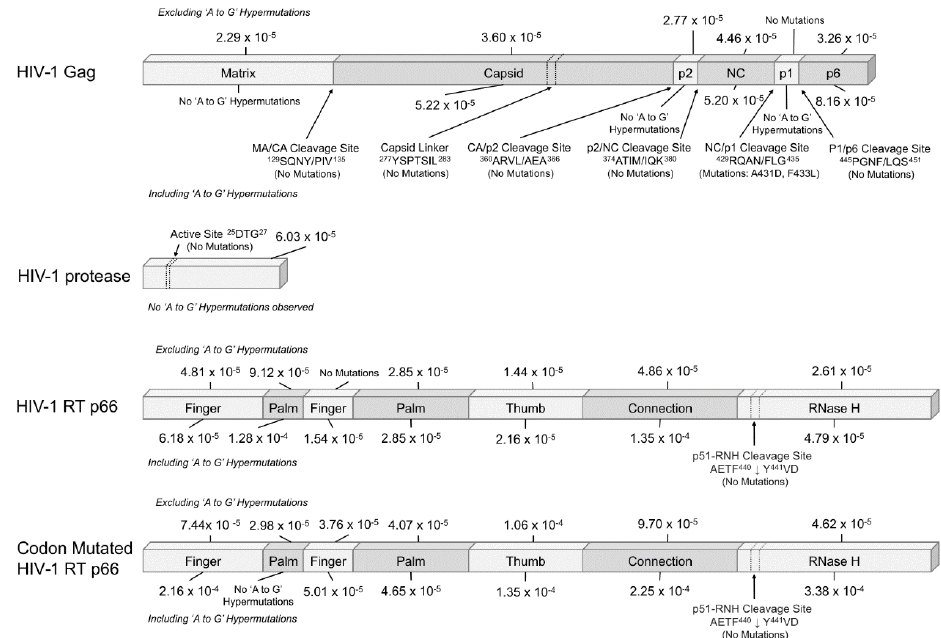
Figure 4. Mutation rates (mutations/bp) calculated in the domains of HIV-1 Gag, protease, RT p66, and Codon Mutated RT p66. Mutation rates were calculated as the ratio of number of mutations observed and the total number of nucleotide bases. Mutation rates were counted separately when including and excluding ‘A to G’ hypermutations. Truncations that span across multiple domains were excluded in calculations. The mutation rates of the respective regions are also shown. For HIV-1 protease, there were no ‘A to G’ hypermutations and no mutations in the active site 25 DTG 27 . For RT p66, when excluding hypermutations, there was a range of 0 to 9.12 × 10 −5 mutations/bp, which increased to 1.35 × 10 −4 mutations/bp when including them. Despite the 2nd finger domain being of similar length as the 1st palm segment, only ‘A to G’ hypermutations were observed in the 2nd finger without other mutations. No muta- tions were observed in the RT p51 and RNase H domain (p51-RNH) cleavage site AETF 440 ↓ Y 441 VD or in the catalytic triad: D110, D185, and D186. For the codon mutated p66, the mutation rate was in the range of 2.98 × 10 −5 –1.06 × 10 −4 mutations/bp when ex- cluding hypermutations and 3.38 × 10 −4 mutations/bp when including them. Contrary to the wild-type p66, there were mutations observed in the 2nd finger domain, suggesting that codon usage of the wild-type 2nd finger domain resisted mutations with the excep- tion of ‘A-G’ hypermutations. Similarly, no mutations were observed in the p51-RNH cleavage site AETF 440 ↓ Y 441 VD despite the different codon usage. Interestingly, ‘A to G’ hy- permutations were not observed in the 1st palm region of the codon mutated p66. 2.3. Flanking Sequences of ‘A to G’ Mutation Sites To explore the possible influence of host defense deaminases e.g., ADAR in causing ‘A to G’ hypermutations, we analyzed the flanking 4 nucleotides (nt) of all the detected ‘A to G’ mutations using the two-sample logo analysis (Figure 5A,C) for comparisons with